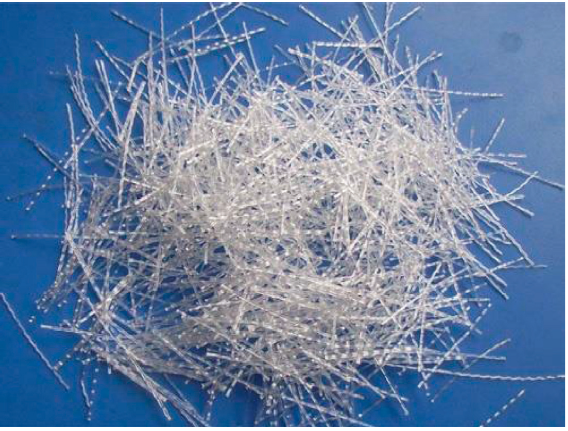
Figure 1: Polypropylene macrofibers. Table 1: Characteristic parameters of polypropylene macrofiber.